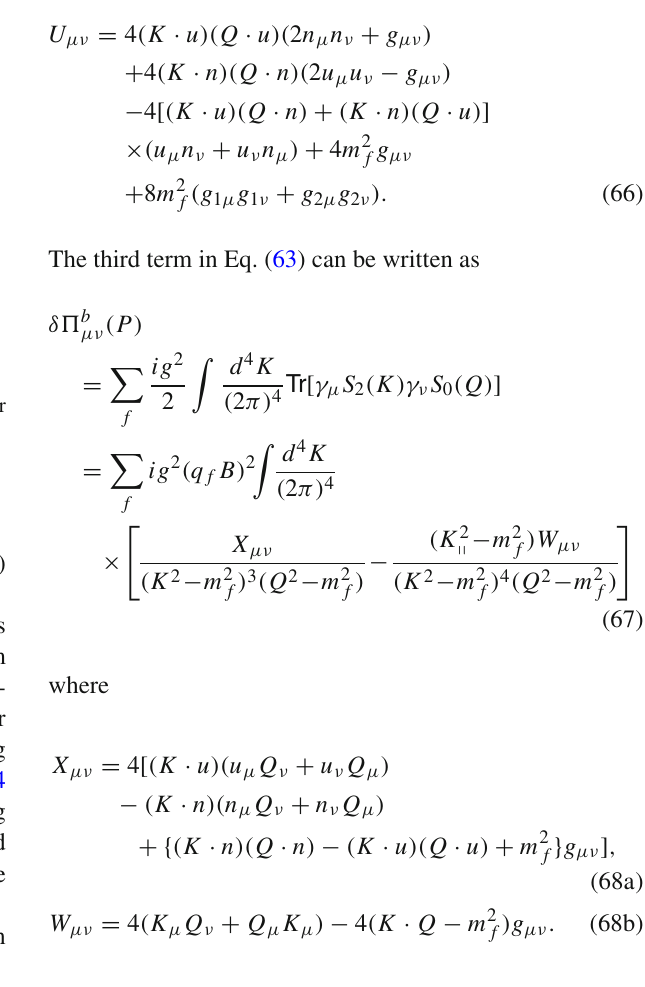
Fig. 4 The order of ( eB ) 2 correction to the gluon polarization tensor (δ(cid:2) a ) in weak field approximation μν